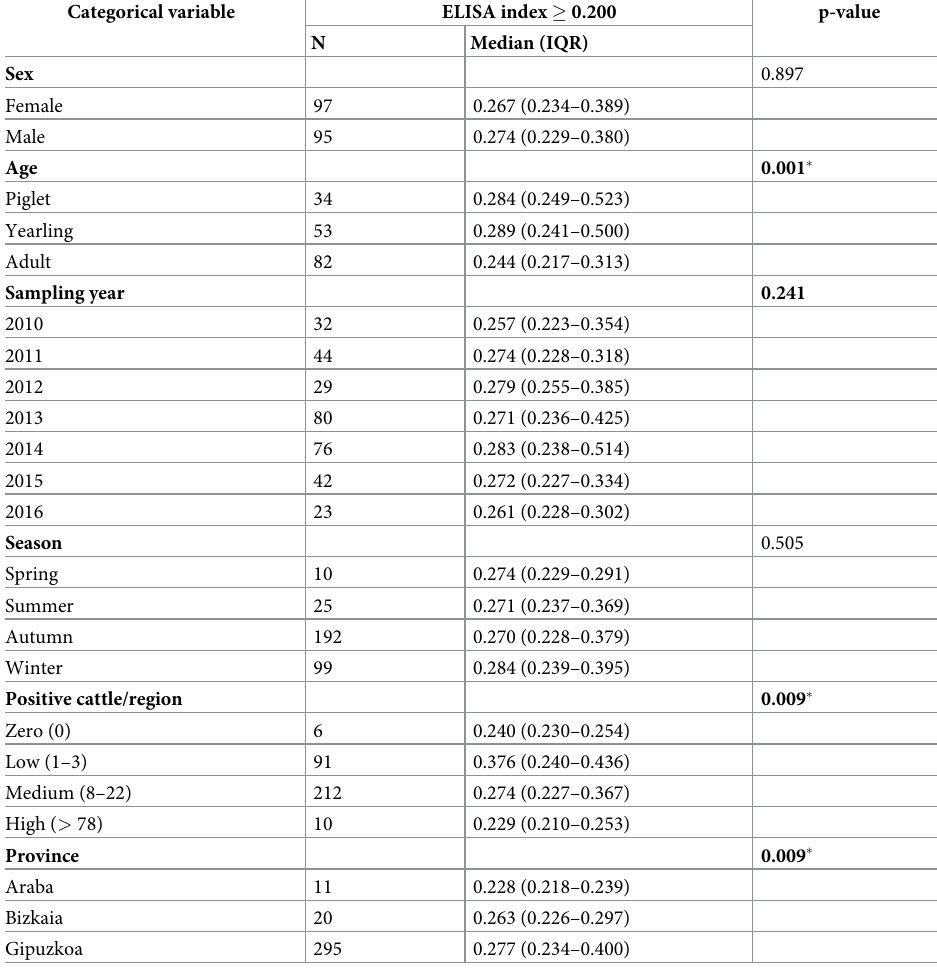
Table 3. Descriptive statistics of the ELISA index of the positive wild boars according to categorical variables. Categorical variable ELISA index � 0.200 p-value N Median (IQR) Sex